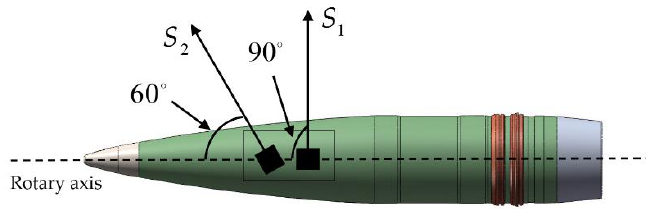
Figure 3. Installation diagram of two uniaxial magnetometers.